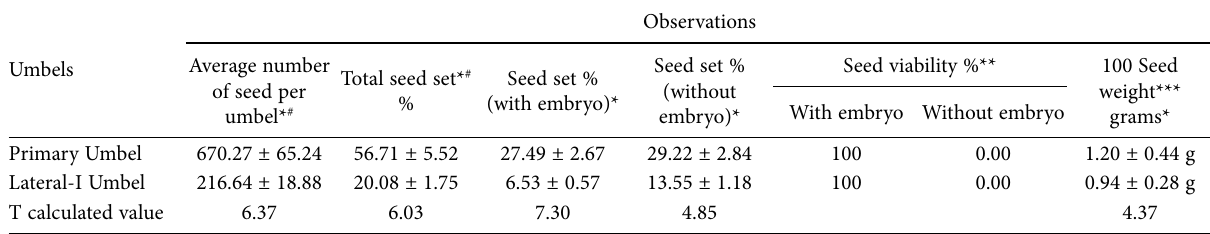
Table 6. Seed set percentage in different umbels of A. glauca :